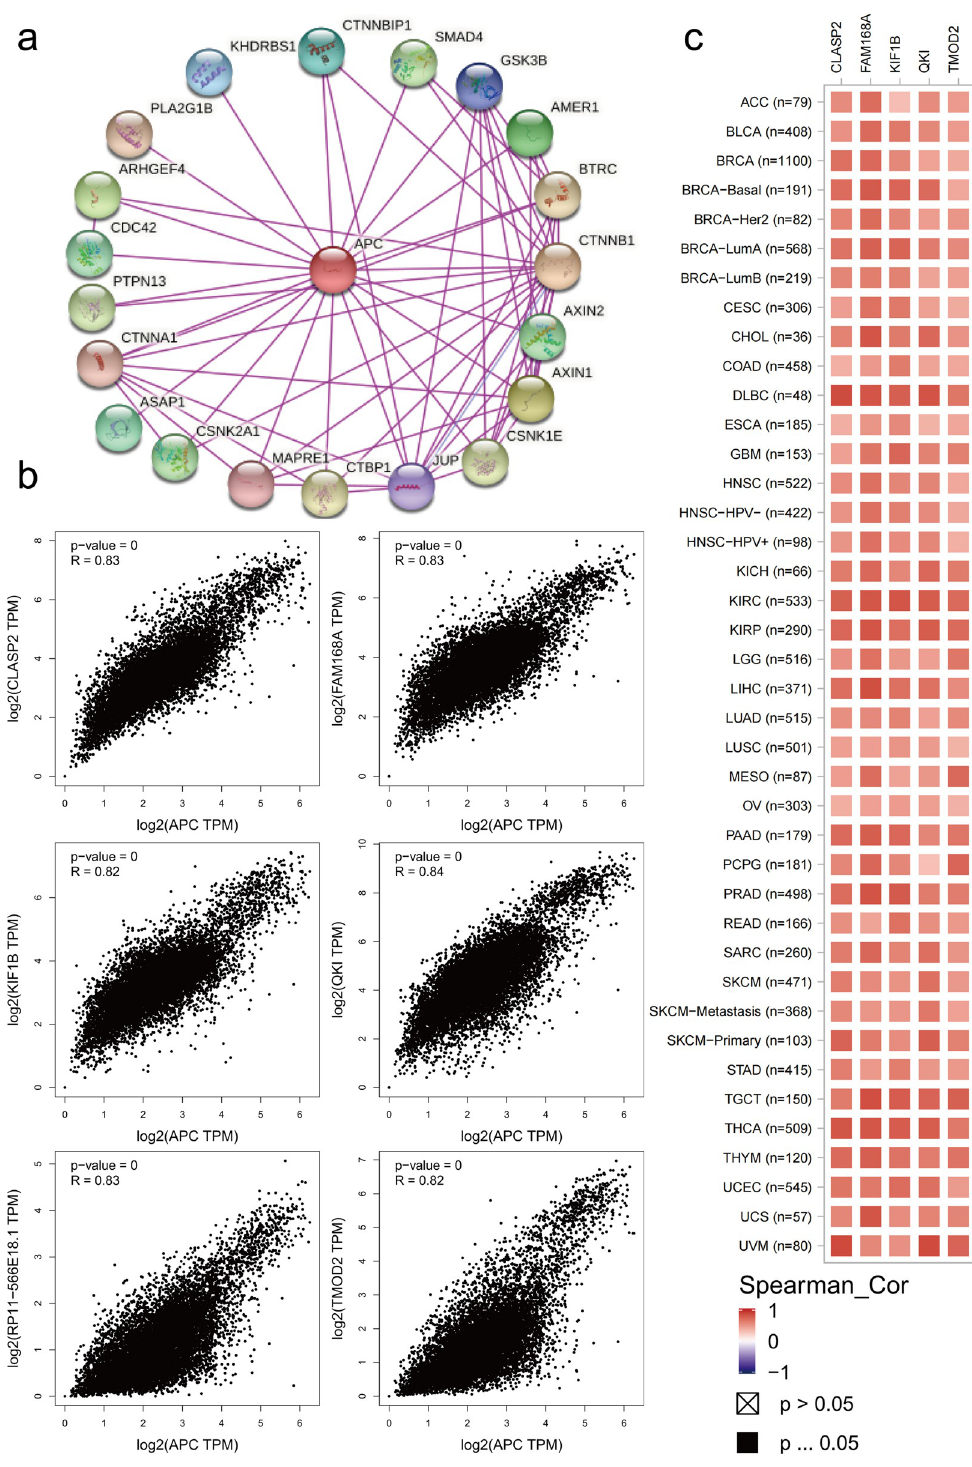
Fig 9. APC targeted gene correlation analysis. (a) The first 20 APC -binding proteins were obtained via STRING tool. (b) The top 100 APC -correlated genes were acquired via the GEPIA2 tool, and the association between APC expression and six genes ( QKI , CLASP2 , RP11-566E18 . 1 , FAM168A , TMOD2 and KIF1B ) was analyzed. (c) The heat map of 5 genes ( QKI , CLASP2 , FAM168A , TMOD2 and KIF1B ) expression in cancers.